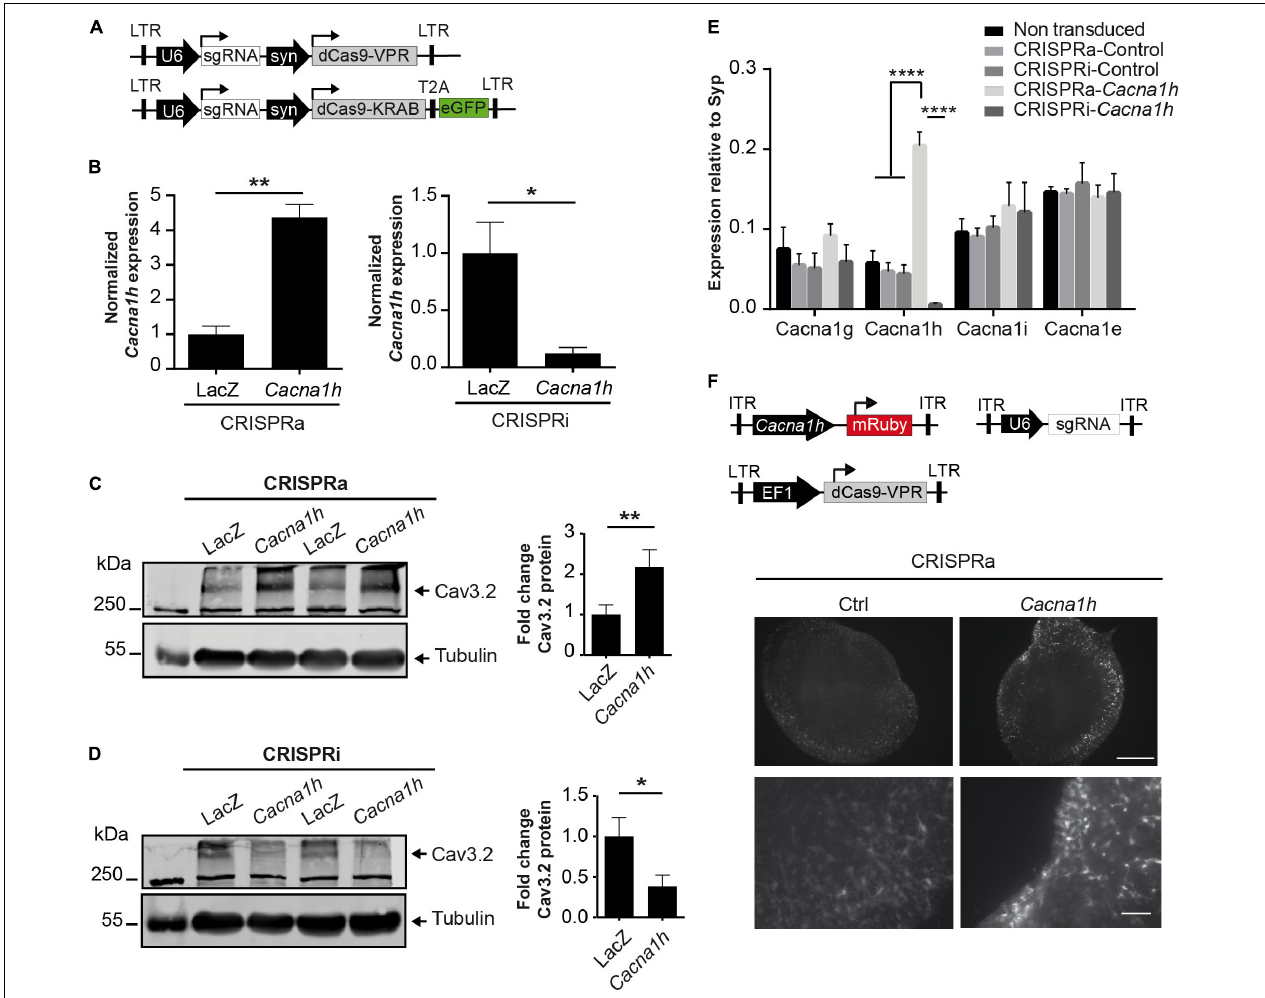
FIGURE 2 | CRISPRa/i modulates the endogenous expression of Cacna1h in primary neurons. (A) Schematic representation of the all-in-one lentiviral constructs for CRISPRa (Lenti-U6-sgRNA-syn-dCas9-VPR) and CRISPRi (Lenti-U6-sgRNA-syn-dCas9-KRAB-EGFP). (B) mRNA expression of Cacna1h in cultured neurons after transduction with the all-in-one lentivirus targeting either Cacna1h or the control ( LacZ ). Expression levels of Cacna1h relative to Synaptophysin in every treatment were normalized to the controls (CRISPRa- LacZ and CRISPRi- LacZ ), N = 3, unpaired t -test, * p ≤ 0.05, ** p ≤ 0.01. (C) Representative western blot and quantification of Cav3.2 protein levels in cortical neurons transduced with the all in one lentivirus for CRISPRa- Cacna1h (or LacZ , as control) ( N = 6, paired t -test), ** p ≤ 0.01. (D) Representative western blot and quantification of Cav3.2 protein levels in cortical neurons transduced with the all in one lentivirus for CRISPRi- Cacna1h (or LacZ , as control) ( N = 5, paired t -test), * p ≤ 0.05. (C,D) Tubulin was used as loading control. Values of Cav3.2/Tubulin were normalized to the controls of each treatment: CRSIPRa- LacZ for CRISPRa and CRISPRi- LacZ for CRISPRi. (E) mRNA expression of different calcium channels in neurons transduced with the all-in-one lentiviral constructs targeting Cacna1h . Expression relative to synaptophysin ( N = 3, Two way ANOVA, Tukey’s multiple comparison test, **** p ≤ 0.0001). (F) Mouse organotypic hippocampal slices transduced with the CRISPRa lentivirus, the AAV-U6-sgRNA and the reporter AAV- Cacna1h -mRuby (Scale bar of 500 µ M for upper and 100 µ M for lower